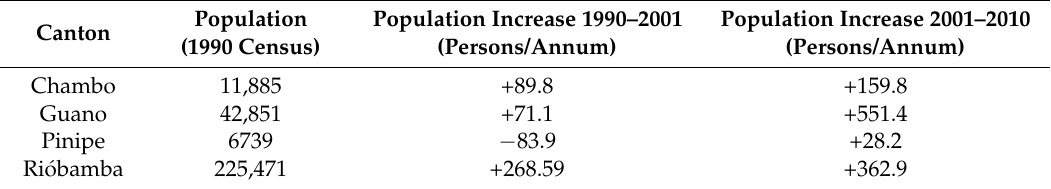
Table 5. Chambo, Guano, Pinipe and Ri ó bamba Cantons: summary population data 1990, 2001 and 2010